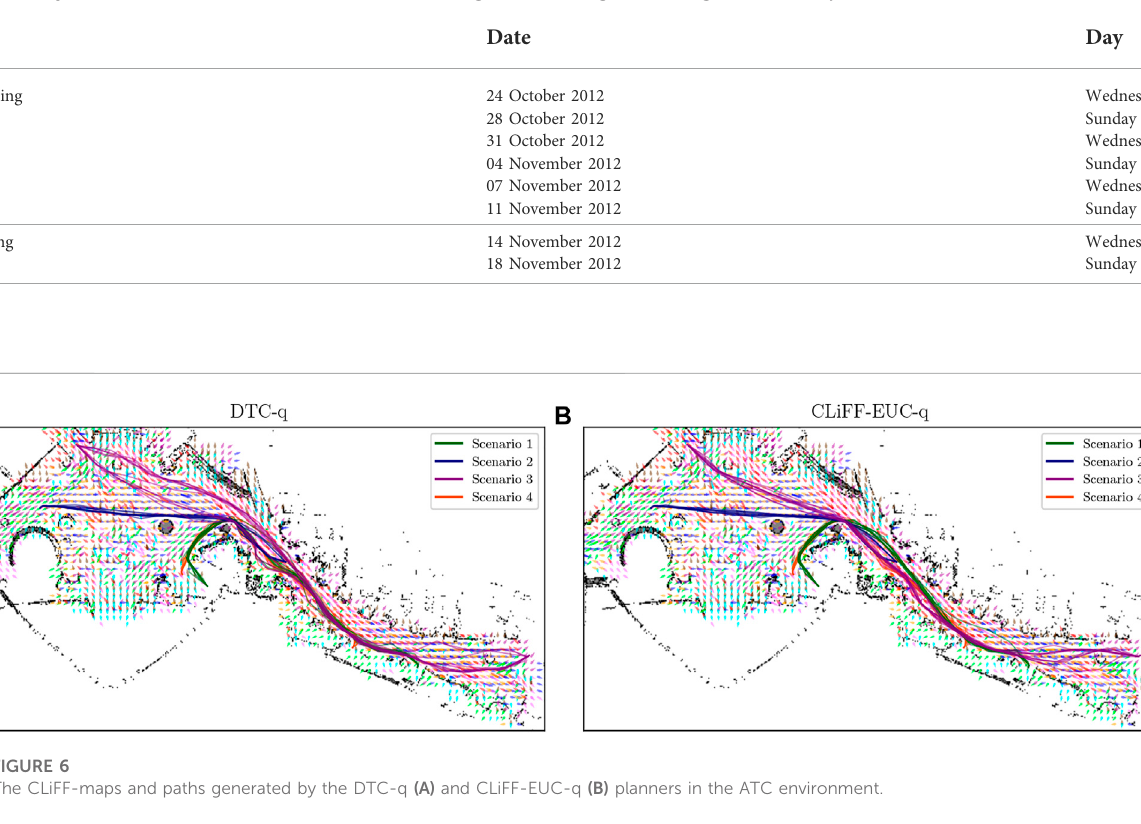
TABLE 1 Days and dates from the ATC dataset used for training (MoD-building) and testing (execution experiments).